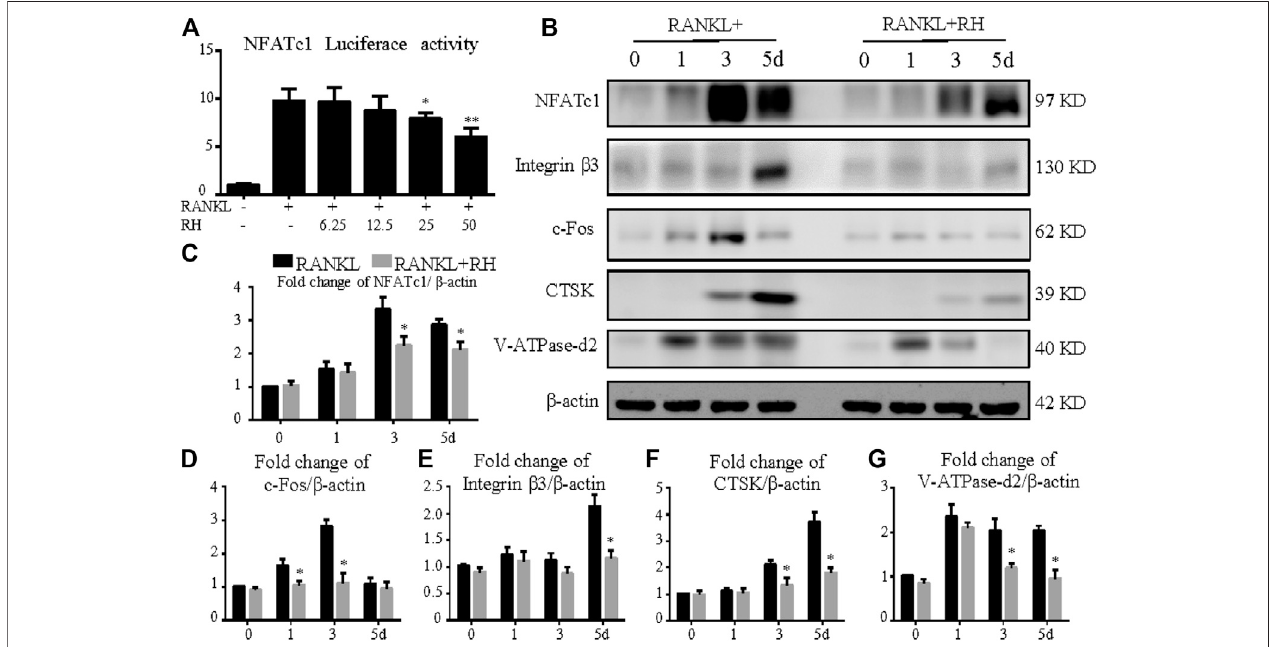
FIGURE 4 | RH suppressed NFATc1 activation and its downstream protein expression. (A) RH inhibited the NFATc1 activity of RAW 264.7 cells transfected with luciferase report construct. The cells were pretreated with RH for 1 hour, followed by RANKL stimulation at 50 ng/ml concentration for 24 hours ( n (cid:2) 4). (B) Representative Westernblot images ofthe effects ofRH on theprotein expression ofNFATc1, integrin β 3, CTSK, c-Fos, and V-ATPase-d2 at day 0, 1,3, and 5with the stimulationofRANKL(50 ng/mL). (C – G) Quanti fi cationoftheratiosofbandintensityofNFATc1,integrin β 3,CTSK,c-Fos,andV-ATPase-d2relativeto β -actin( n (cid:2) 3). * p < 0.05, ** p < 0.01 relative to RANKL-induced control